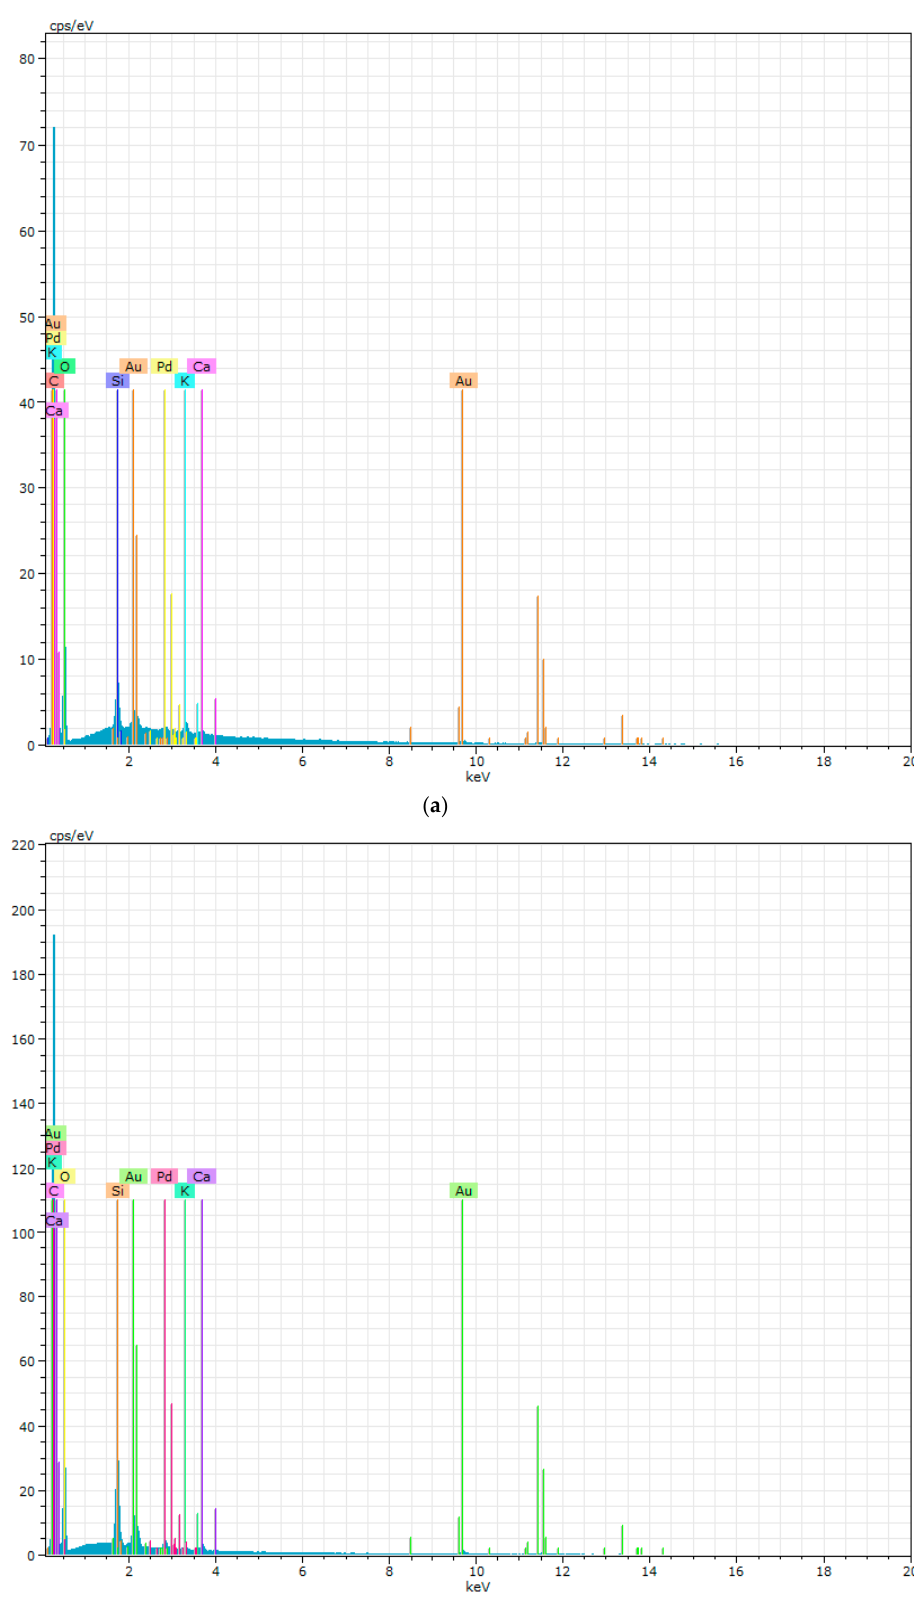
Figure 11. The EDX of PURs ( a ) and PURs-M ( b ) after calcification study.